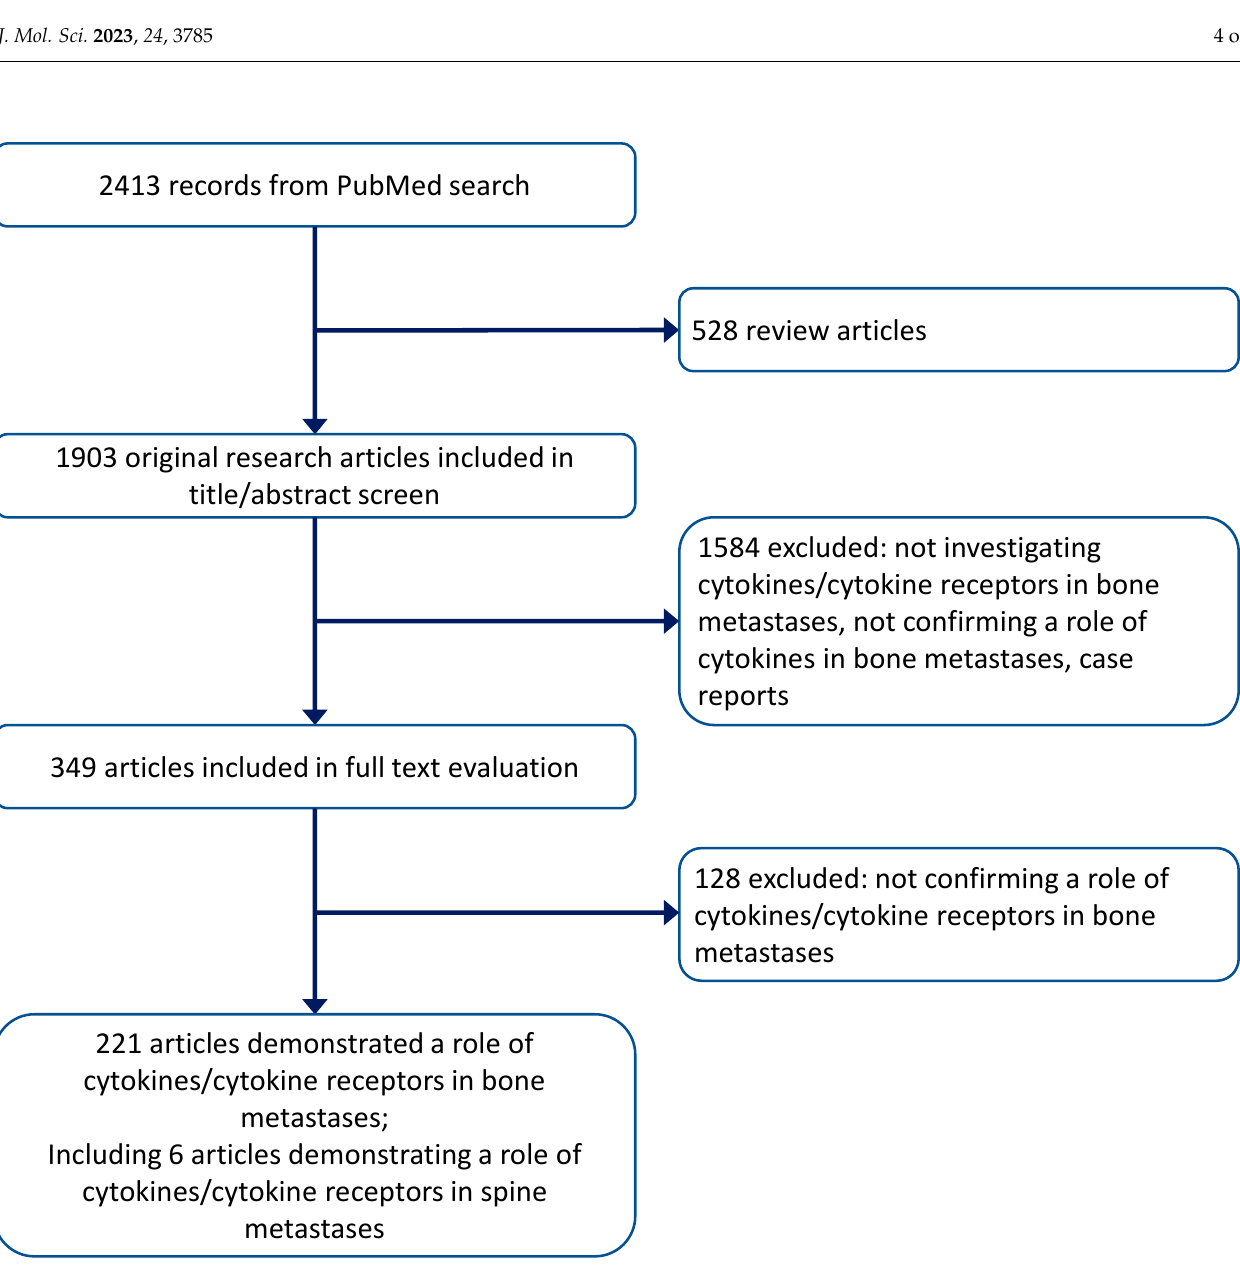
Figure 1. Preferred Reporting Items for Systematic Reviews and Meta-Analyses (PRISMA) flow chart of search criteria.